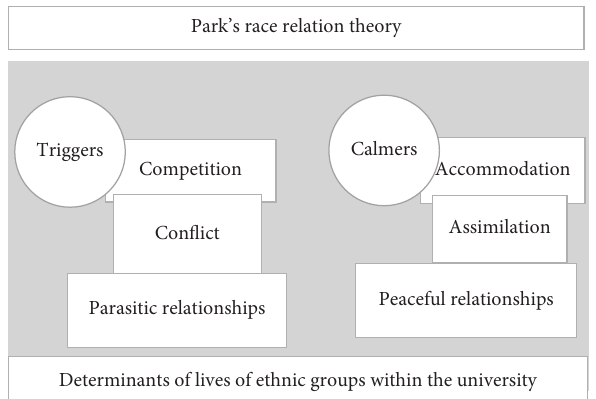
Figure 1: Race relation theory used in the present study. Source: Park